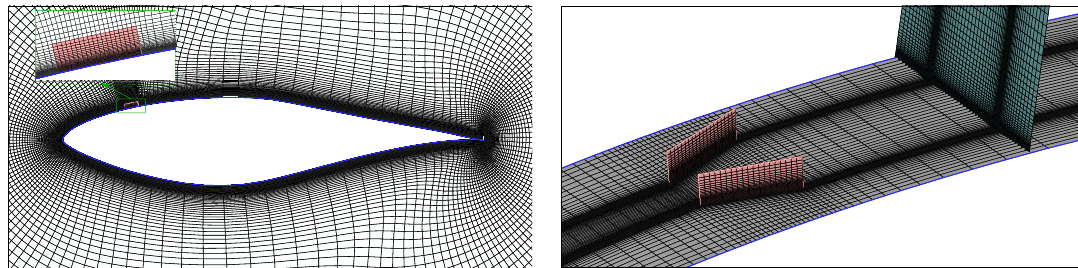
Figure 3. Boundary-layer and surface mesh of the airfoil with single-row VGs.